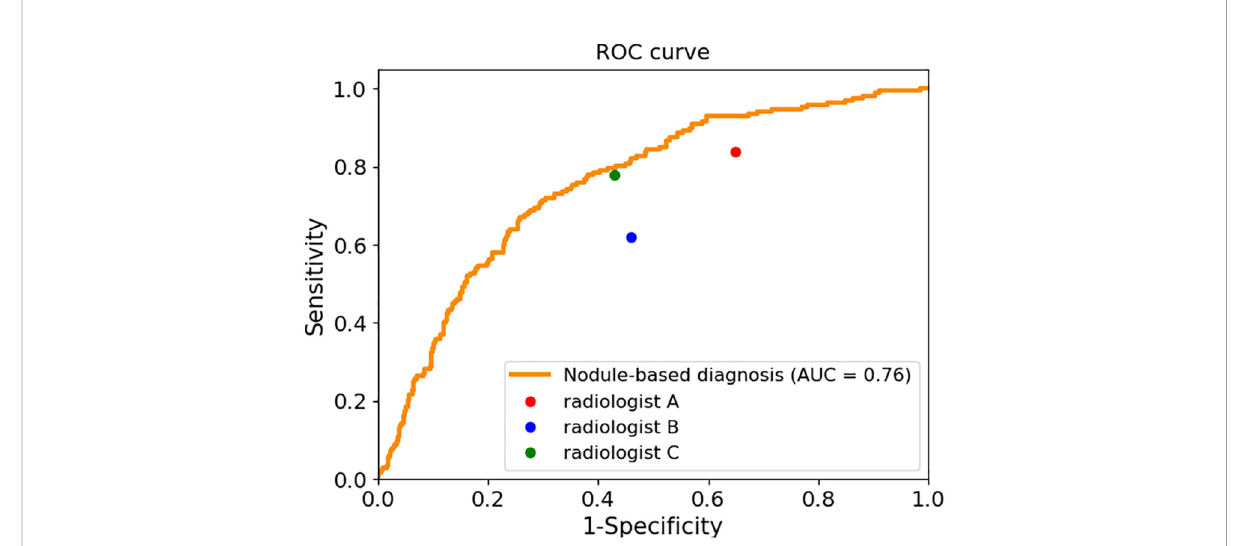
FIGURE 1 The sensitivity and speci fi city of three radiologists and the ROC curve and AUC value of the AI